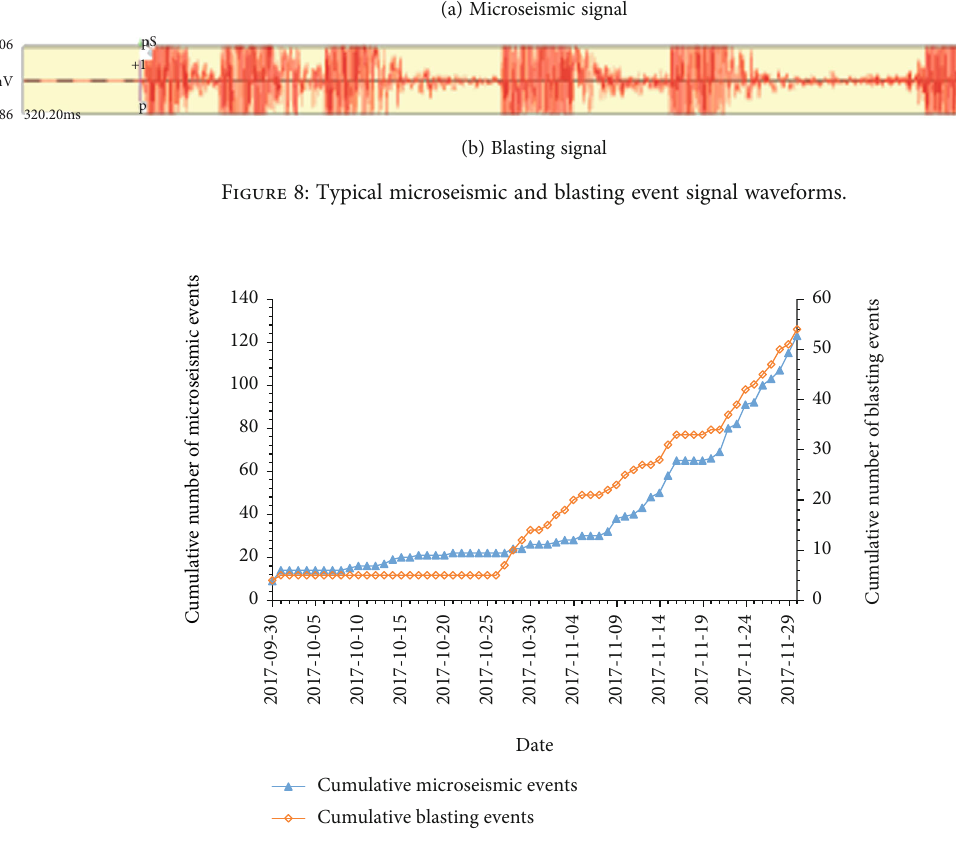
Figure 9: Evolution of accumulative microseismic events and blasting events over